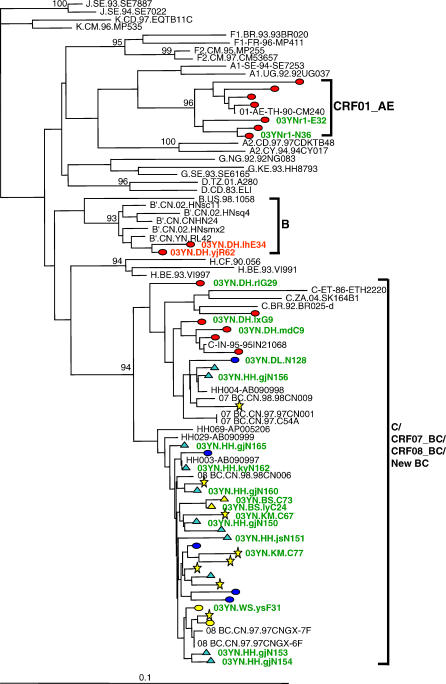
Phylogenetic Neighbor-Joining Tree for HIV-1 RT Fragment Sequences Obtained from 43 IndividualsIndividual sequences are color coded, with the colors corresponding to those of original geographic sites on the map of Yunnan (Figure 1). The horizontal branch was drawn in accordance with their relative genetic distances. The vertical lines are present purely for clarity of the tree presentation. The bootstrap values based on 1,000 replicates are labeled on the major branches. The reference sequences for classifying HIV-1 genotypes were included and were originally obtained from the NIH/NIAID–funded HIV Databases.